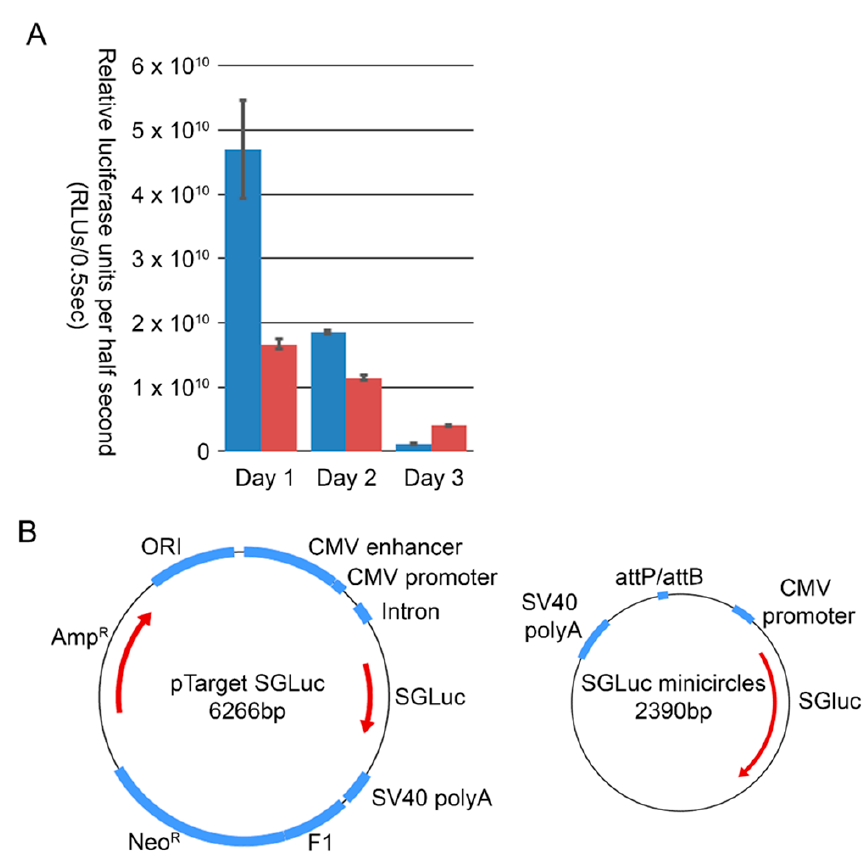
Figure 4. ( A ) Relative luciferase units per half second of IBRS2 cells transfected with either traditional plasmid, pTarget (blue), or minicircles (red), expressing the SGLuc reporter and monitored over three days of expression. ( B ) Minicircles are less than half the size of pTarget, they do not contain additional features to enhance transgene expression, such as chimeric intron and CMV enhancer sequences.